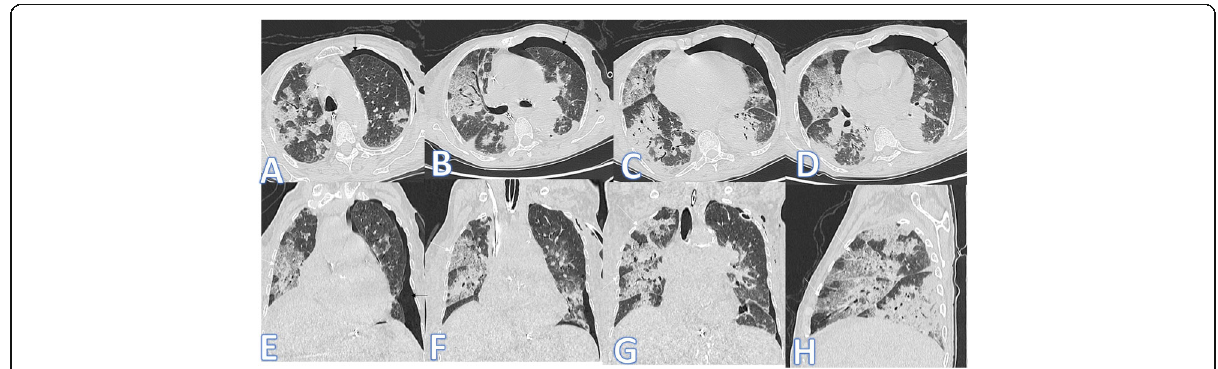
Fig. 13 A 72-year-old female patient presented with severe dyspnea with desaturation. She was intubated. CT chest revealed bilateral symmetric confluent patches of ground glass with crazy paving appearance mixed with consolidative patches with air bronchogram more in the lower lobes (white arrows) more on the right side. LT side mild pneumothorax was noted (black arrows). It was diagnosed as AIP after transbronchial